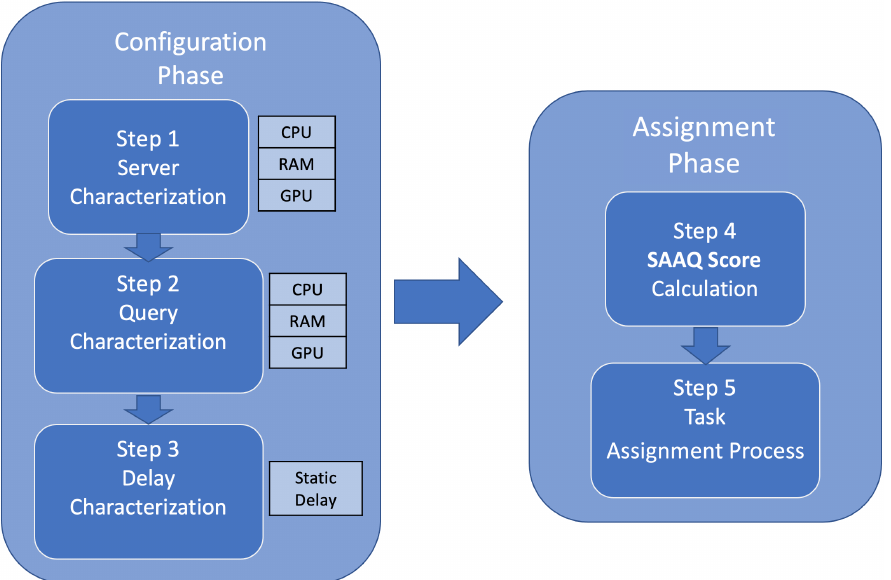
Figure 2. SAAQ methodology